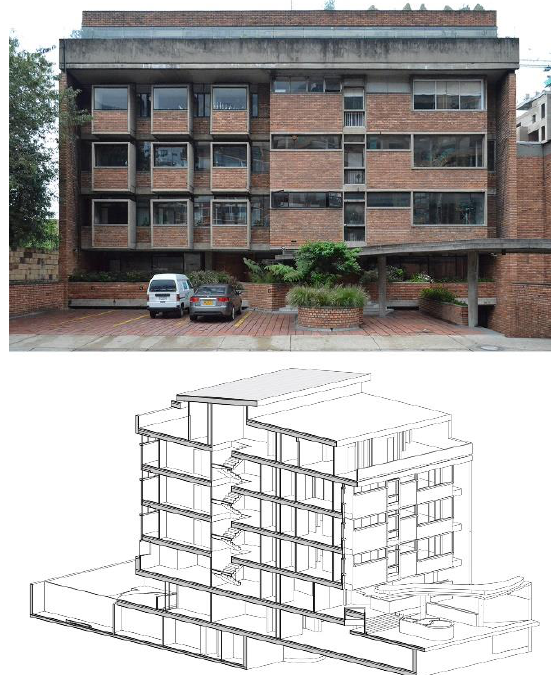
Figure 3. Fernando Martìnez Sanabria, Edificio Giraldo (1958), Bogotà. View of the built architecture (on the top) and axonometric